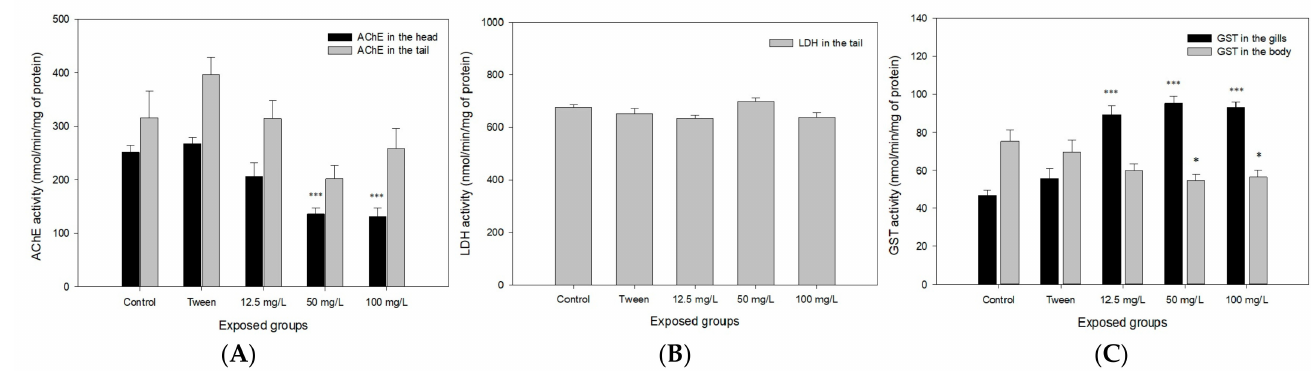
Figure 7. ( A ) AChE activity in the head and in the tail (mean values + standard error) of zebrafish adults after 96 h of exposure to polyethylene microplastics. Asterisks mean significantly different from the respective control ( p < 0.001). ( B ) LDH activity in the tail ( p > 0.05), and ( C ) GST activity in the gills (*** p < 0.001) and body (* p <